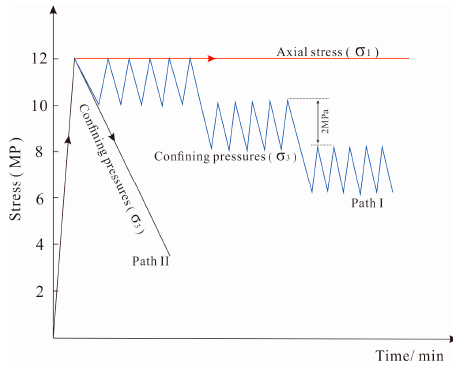
Figure 3. Unloading path.